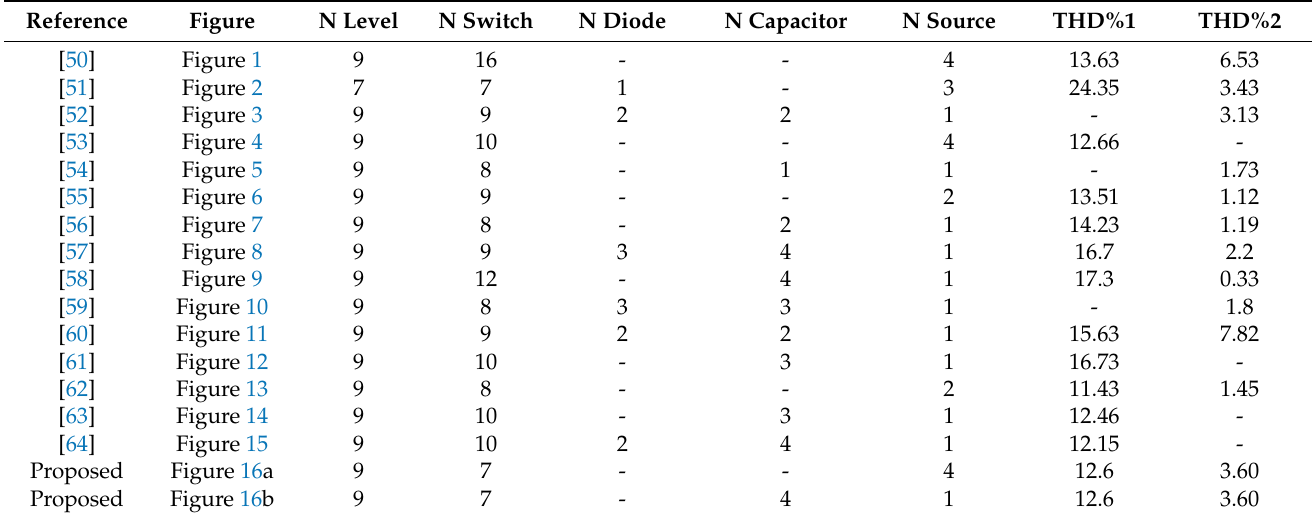
Table 3. Comparison of the proposed MLI topology with other